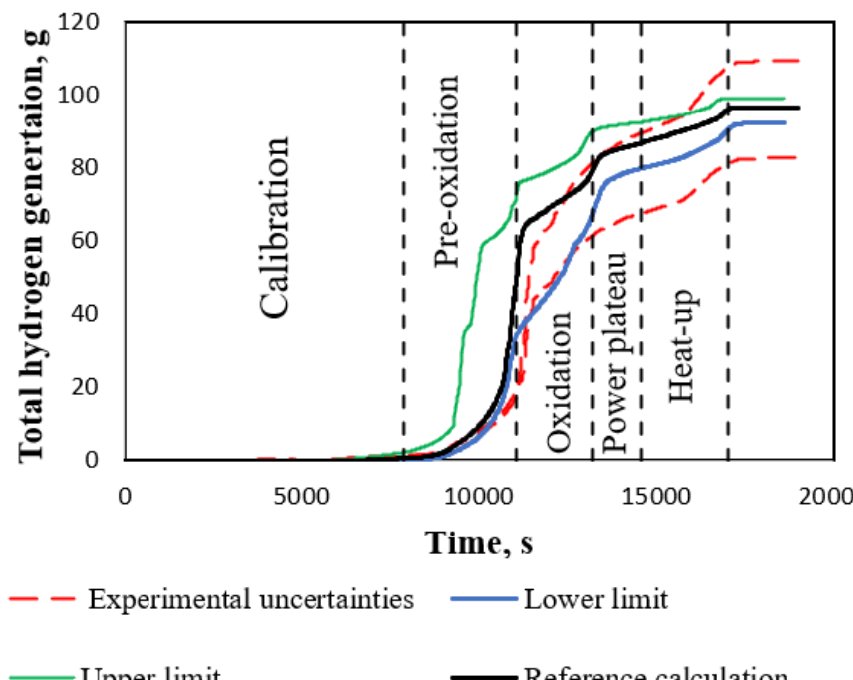
Figure 8. Experimental data with uncertainty bound of total hydrogen generation, reference case calculation, Upper and Lower uncertainty limits.